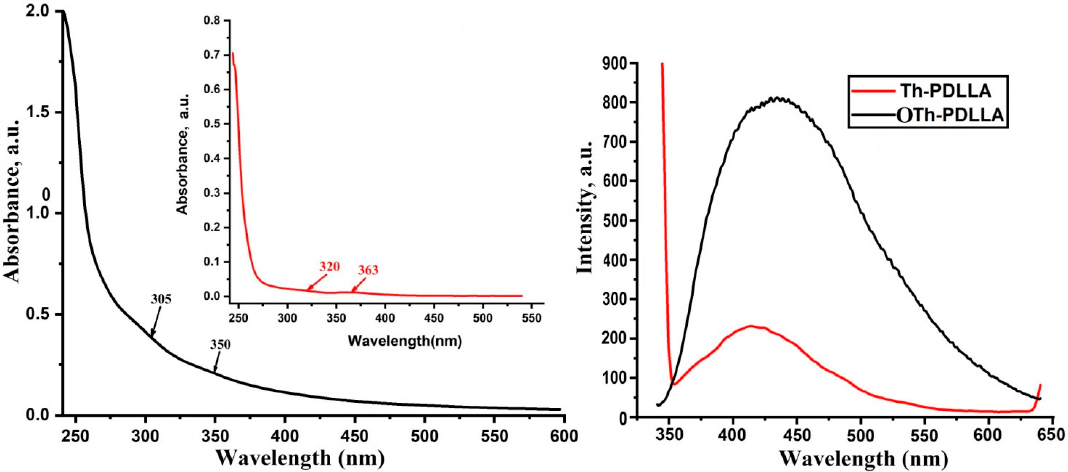
Figure 6. UV–vis and fluorescence spectra of OTh-PDLLA in chloroform (c = 1mg/mL) ( λ ex = 330 nm).